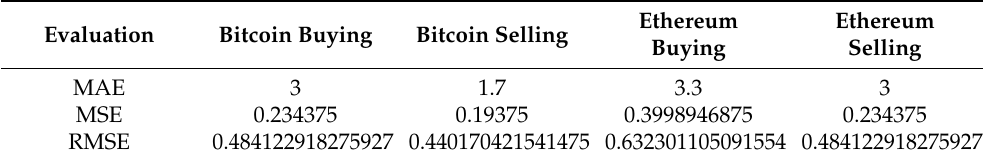
Table 3. Evaluation metrics of